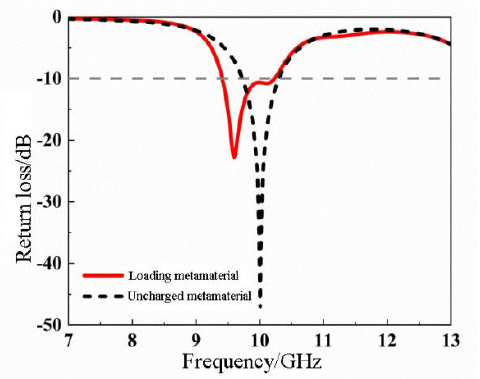
Figure 9. Comparison of the return loss curves of the microstrip antenna loaded with metamaterials and a reference antenna.